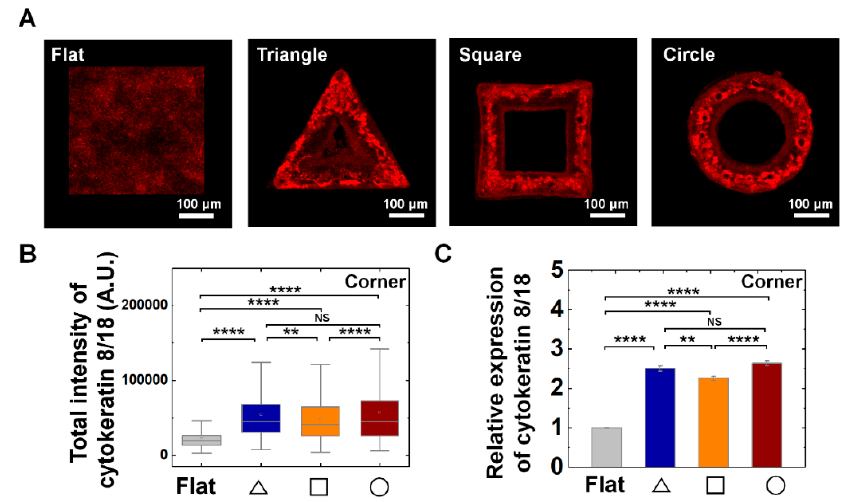
Figure 5. Enhanced cytokeratin 8/18 expression on convex geometric structure. ( A ) Representative fluorescence images of cytokeratin 8/18 (CK8/18; red) in MDCK cells on the flat and triangle, square, circle structure. ( B ) The box plots indicate the total intensity of CK8/18 per individual cells on corner of triangle (navy), square (orange), and circle (red) structure. The result from flat surface is plotted in gray color as a control (N = 5). ( C ) Mean relative CK8/18 intensity of the cells on the geometric structure compared to that on the flat surface. N cell for flat surface and triangle, square, circle structure was 4761 and 571, 799, 1324, respectively (N = 5). Error bars in graph indicate S.E.M. One-way ANOVA with post-hoc Fisher’s LSD was used. **** p < 0.0001; ** p < 0.01; NS, non-significant.